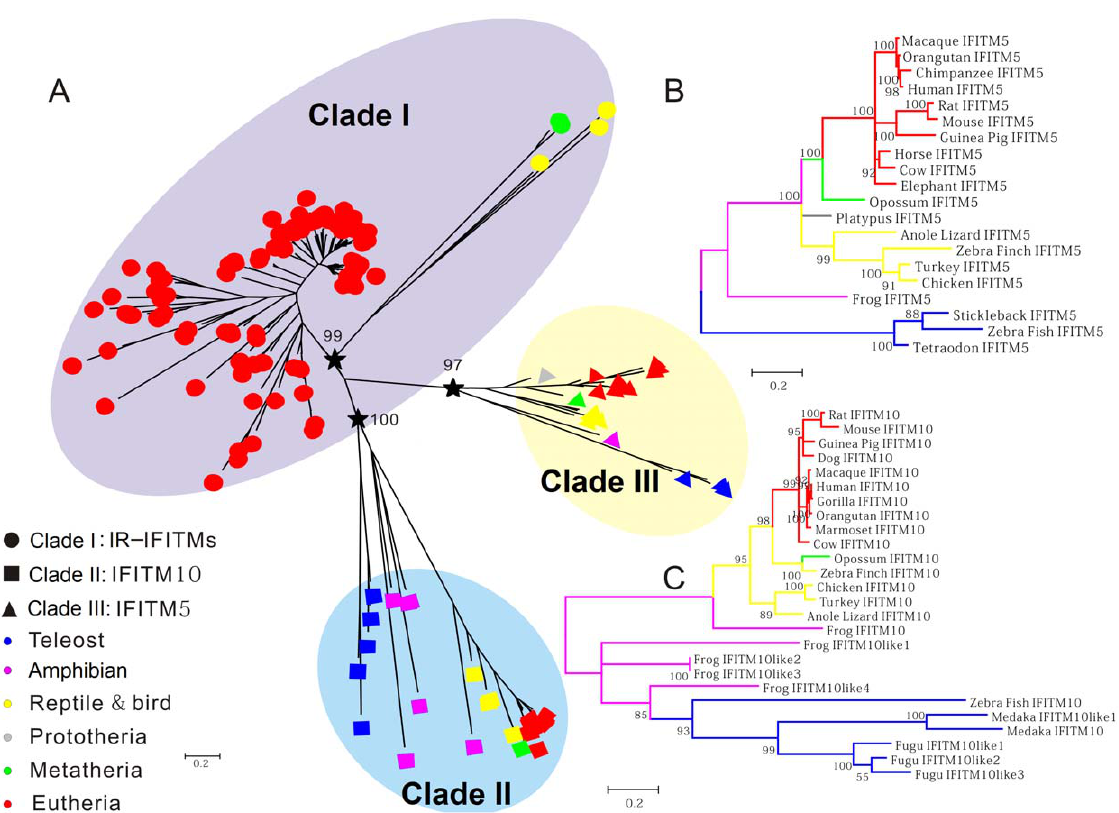
Figure 2. Bayesian tree of the vertebrate IFITM gene family. Bayesian tree was constructed by MrBayes v3.1.2 with 8 million generations. Branch confidence values are shown at the nodes. Scale bar corresponds to 0.2 substitutions per site. ( A ) Phylogenetic tree of all IFITM genes. ( B ) Sub-tree of IFITM5 genes. ( C ) Sub-tree of IFITM10 genes. Three stars represent 3 earlier progenitors of the IFITM family. Circle, square and triangle represent immunity-related IFITM, IFITM10 and IFITM5 genes, respectively. Different colors indicate different